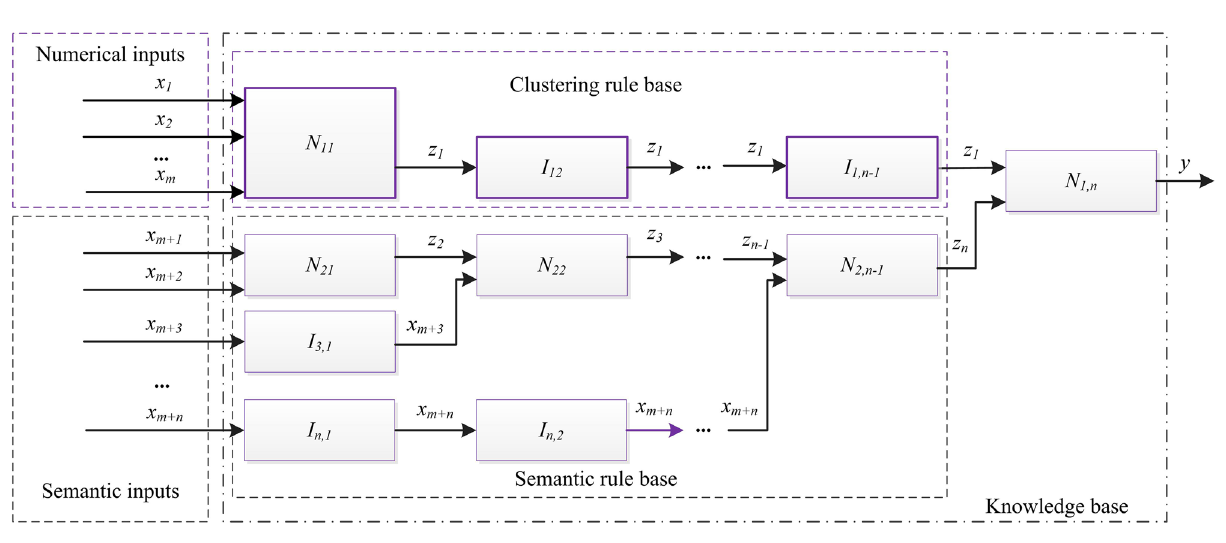
Figure 7. FN structure of the proposed